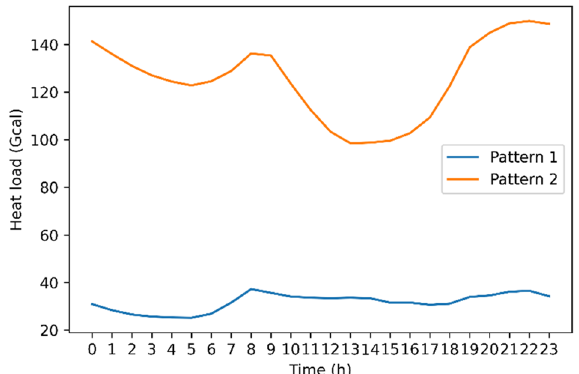
Figure 4. Notable patterns for the daily heat load variation using the clustering technique.